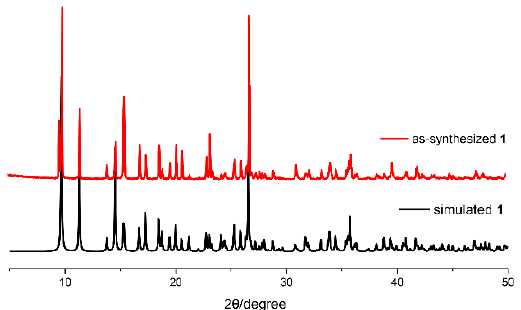
Figure 2. The powder X-ray diffraction (PXRD) patterns of 1 .